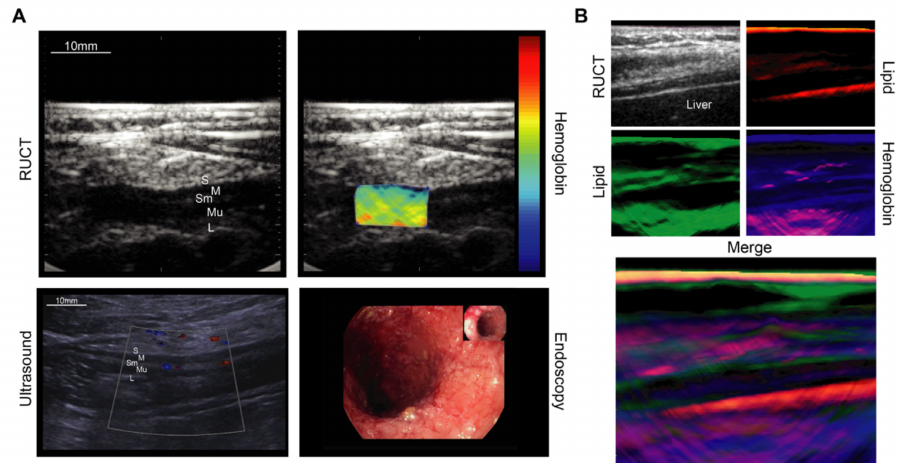
Figure 4. Multispectral optoacoustic tomography (MSOT) of intestinal inflammation using hemoglobin as a surrogate for disease activity. The technique enables hybrid imaging together with B-mode ultrasound imaging (RUCT). ( A ) MSOT imaging of the liver in humans enabling the generation of signals for different subcellular compounds; ( B ) S = serosa, M = muscularis mucosa, Sm = submucosa, Mu = mucosa, L = lumen, RUCT = reflectance ultrasound computed tomography. Figure ( A ) reproduced and modified from [131]. (https://creativecommons.org/licenses/by/4.0/ (accessed on 9 April